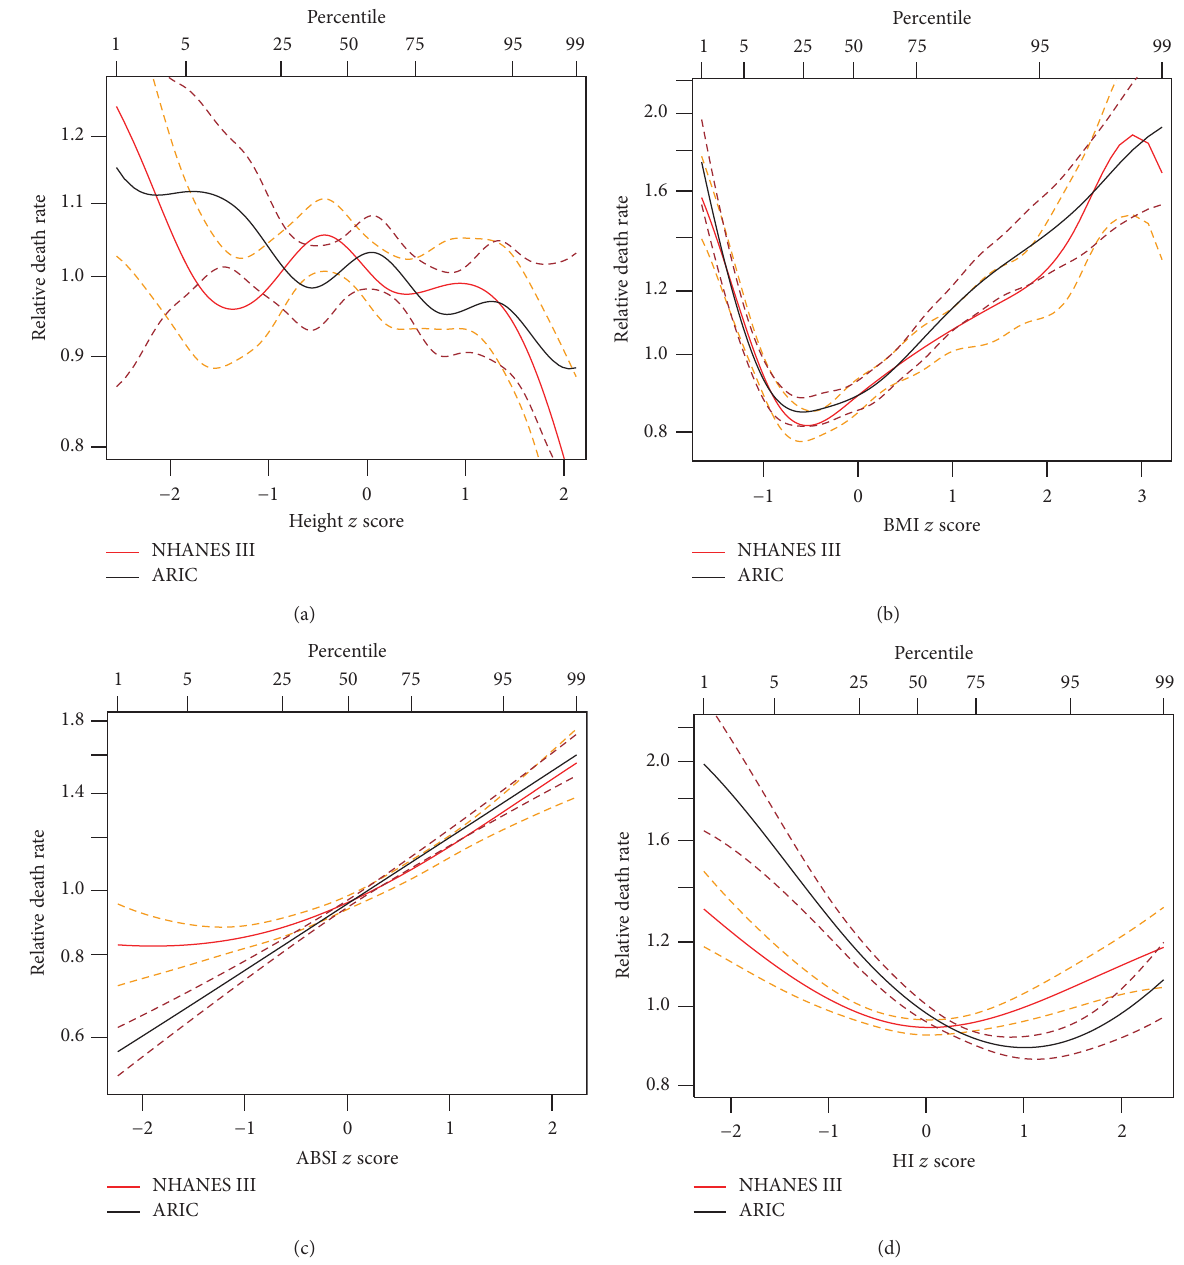
Figure 1: Estimated mortality hazard ratios in NHANES III and ARIC as nonlinear (penalized spline) functions of normalized (a) height, (b) BMI, (c) ABSI, and (d) HI. Dashed lines indicate 95% confidence intervals. Percentiles and 𝑧 scores are based on the NHANES III